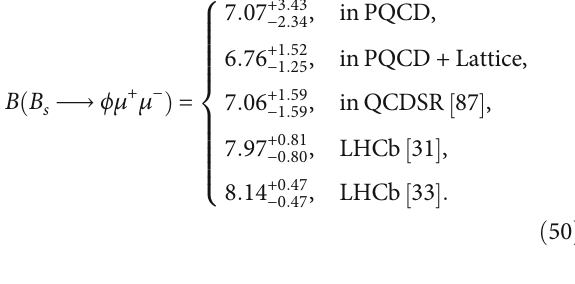
in Equation (48) for the form factors i ,pole